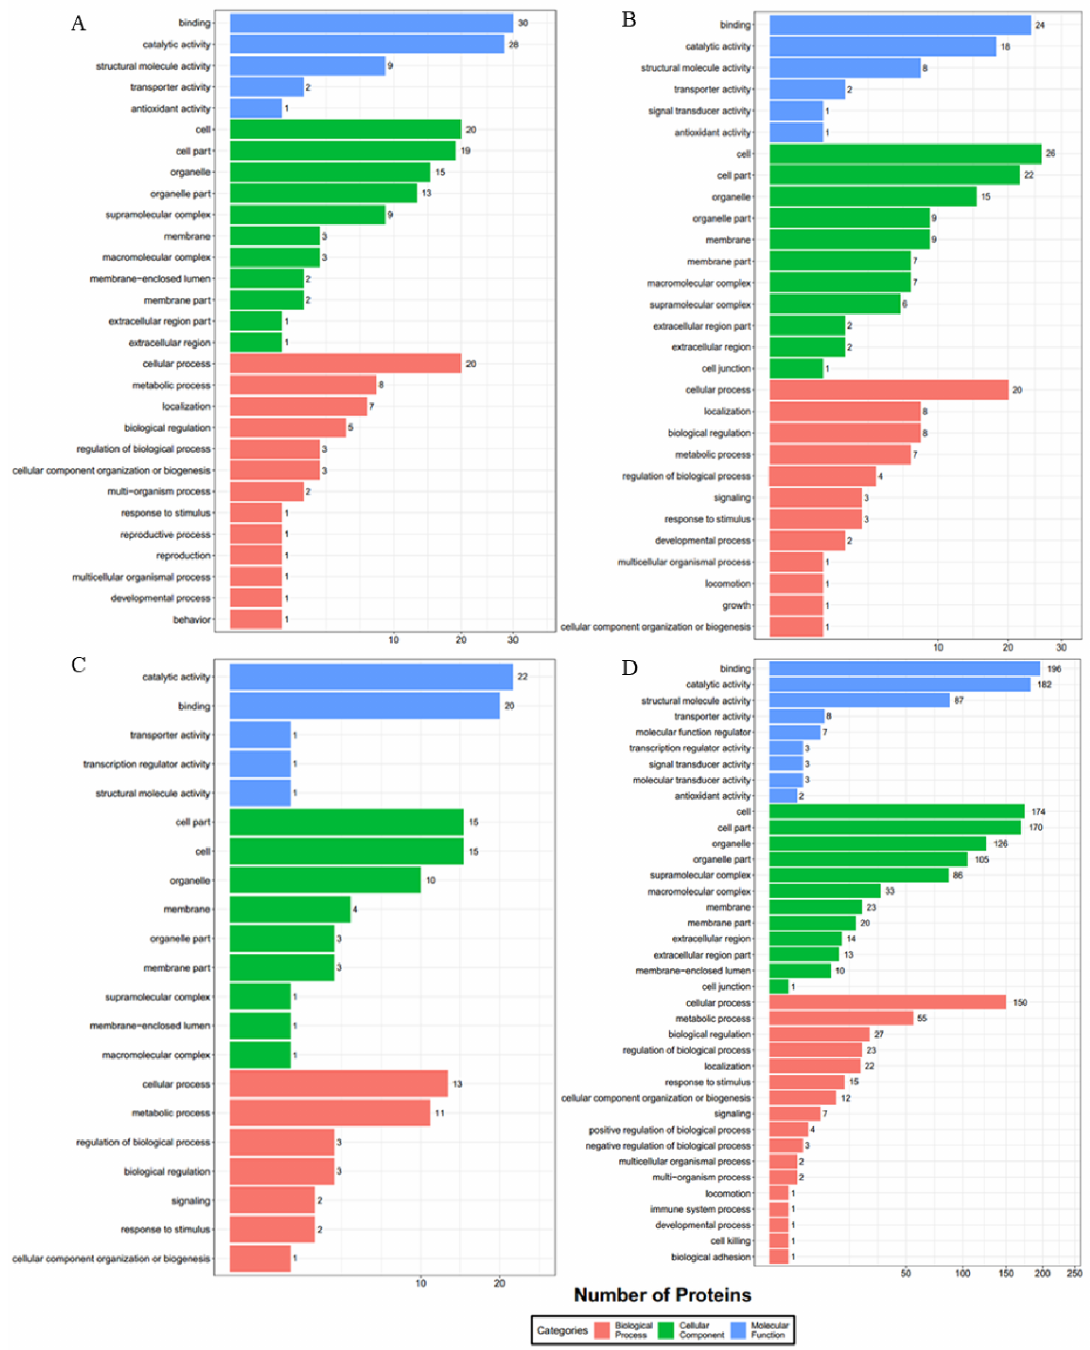
Figure 2. Prey proteins’ distribution by GO at level 2 for bait ORF72 (Red: Biological process; Blue: Molecular function; Green: Cellular component). Numbers shown in the chart represent the number of prey proteins with corresponding GO terms. Subfigures ( A – D ) correspond to the results of GO analyses for the identified proteins in bands a, b, c and d. For bait ORF25 (Figure 5), a urease accessory protein (protein ID: A0A210Q5K3_MIZYE), an alpha-amylase (protein ID: V4AAC3_LOTGI) and an actin (protein ID: